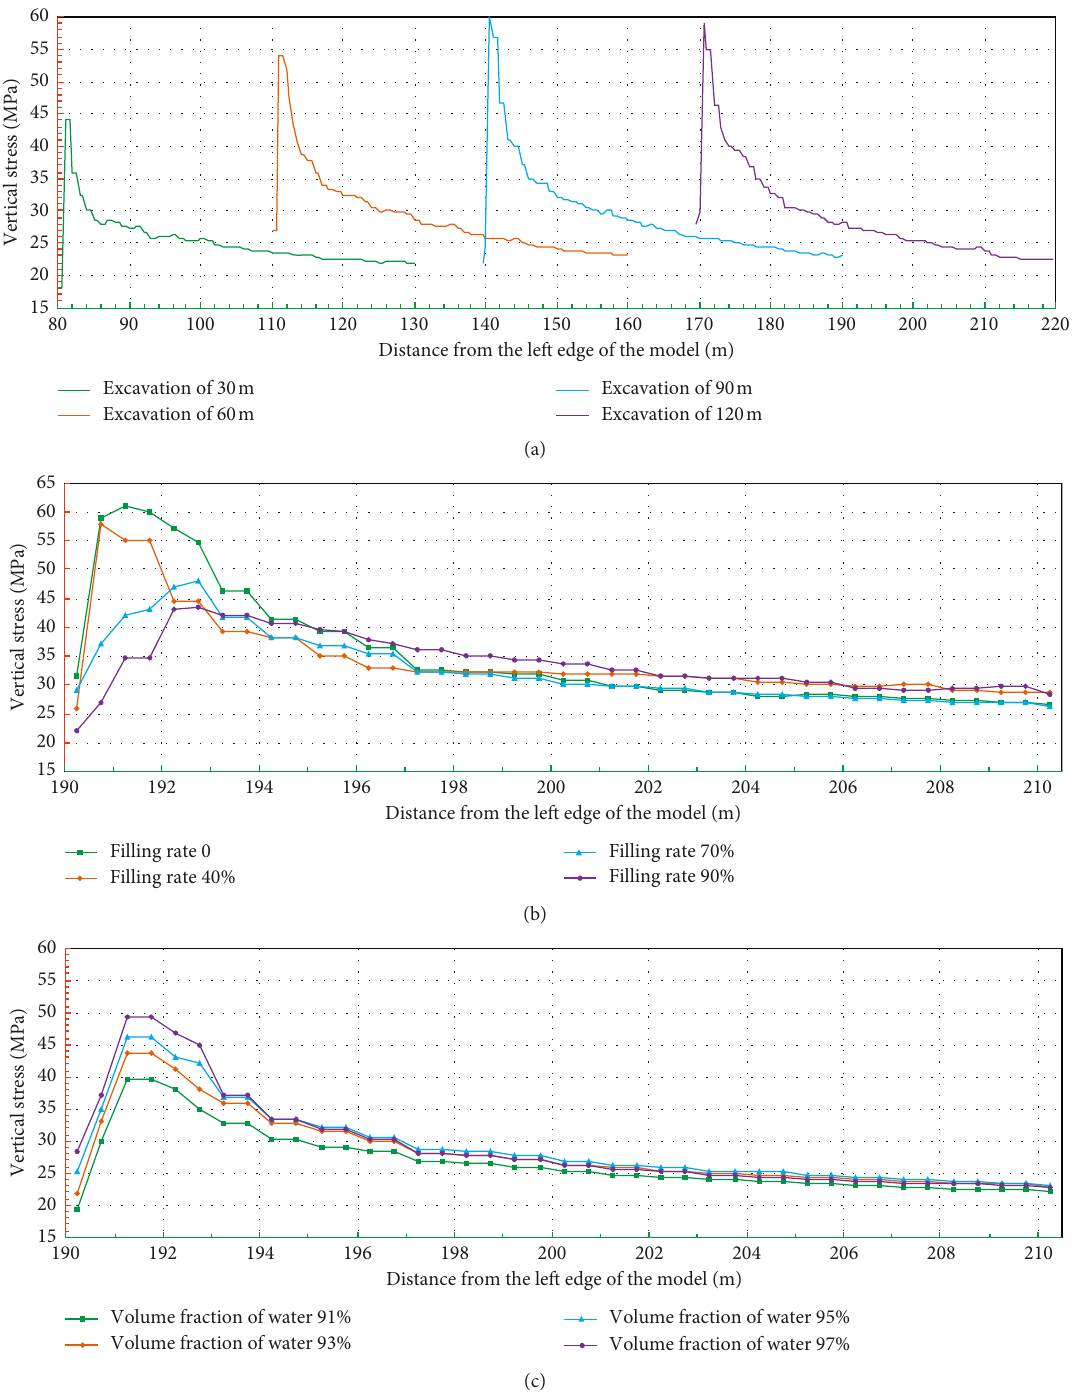
Figure 8: Concentrated vertical stress curves vary with excavation length and filling rate. (a) Different excavation length. (b) Different filling rate. (c) Different volume fraction of